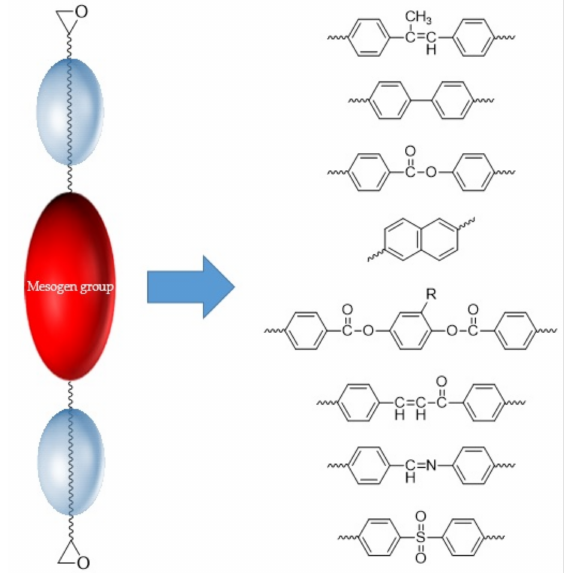
Figure 3. Typical molecular structure of mesogenic